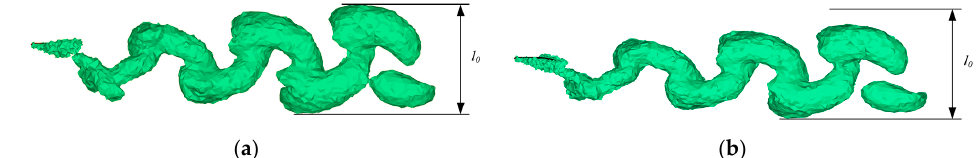
Figure 15. Three-dimensional vortex pattern in the wake of the crescent-shaped foil: ( a ) γ = 20°; ( b ) γ = − 20°.